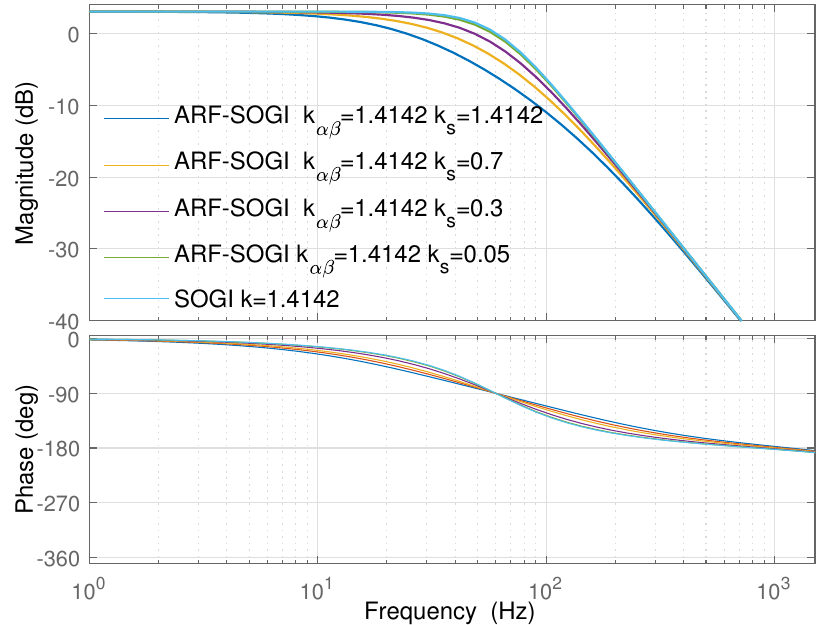
Figure 5. Bode diagrams of the SOGI-QSG versions for qv (cid:48) .